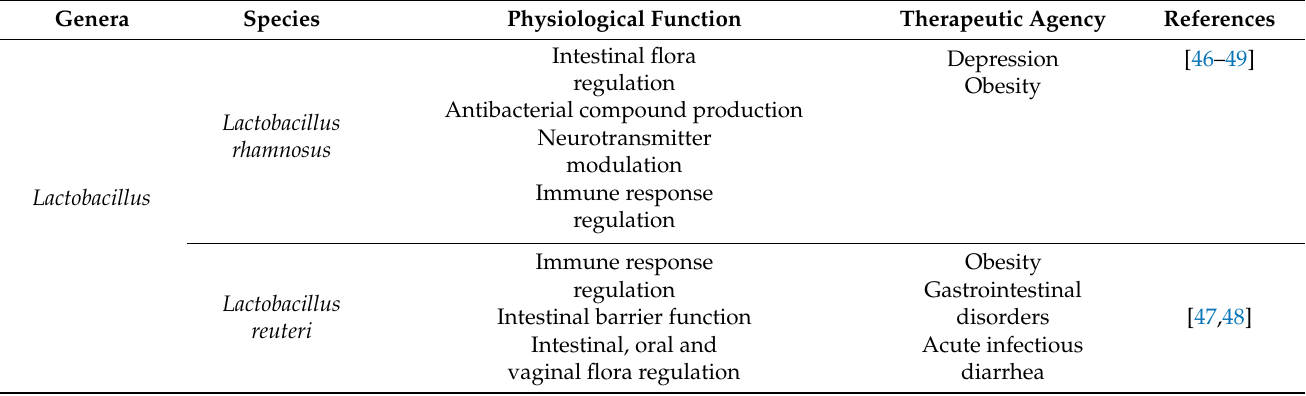
Table 1. Common bacterial genera in probiotics applications including their physiological functions and their areas of therapeutic